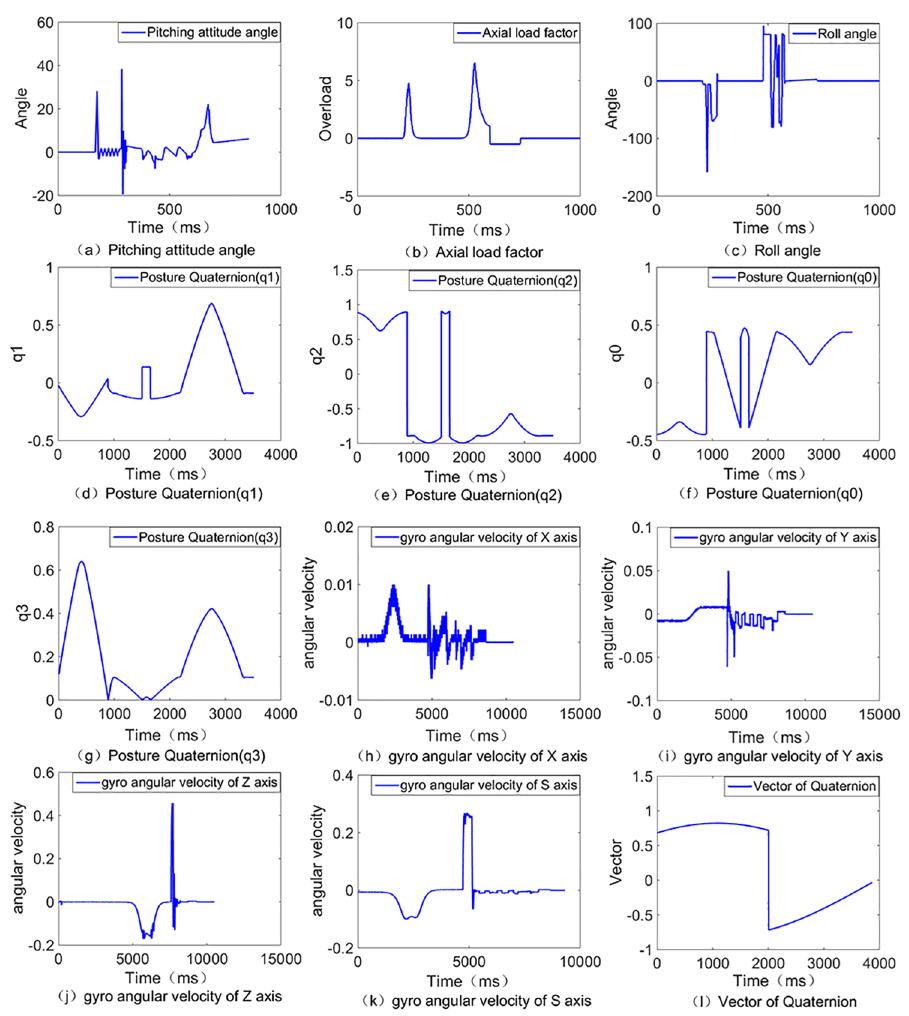
Fig 8. Physical meaning of some electrical properties data. There are 19 different types of signals, and sample labels from 13 modes in the spacecraft flying data are presentedin this study. A total of 22800 samples were acquired,where each sample contained1000 features. More specifically, the physicalmeaning of the data is shown in Fig 8, combiningtwelve elementsof the physicalprocess: (a)Pitchingattitude angle, (b)Axial load factor, (c)Roll angle, (d)Posture Quaternion(q1), (e)Posture Quaternion(q2), (f)Posture Quaternion(q0), (g)Posture Quaternion(q3), (h)Gyro angular velocity of X axis, (i)Gyro angularvelocity of Y axis, (j)Gyro angularvelocity of Z axis, (k) Gyro angularvelocity of S axis, (k) Vector of Quaternion.